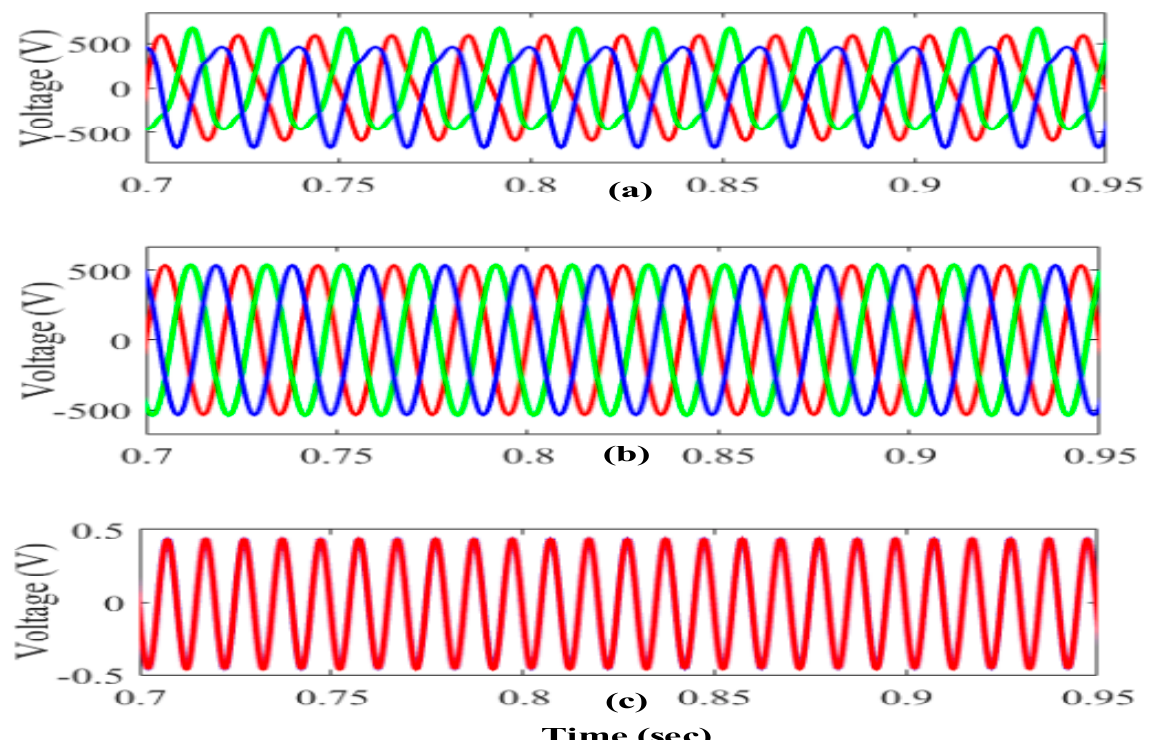
Figure 19. Analysis of voltage disturbance conditions ( a ) Source Voltage ( b ) Load Voltage ( c ) Injected Voltage.